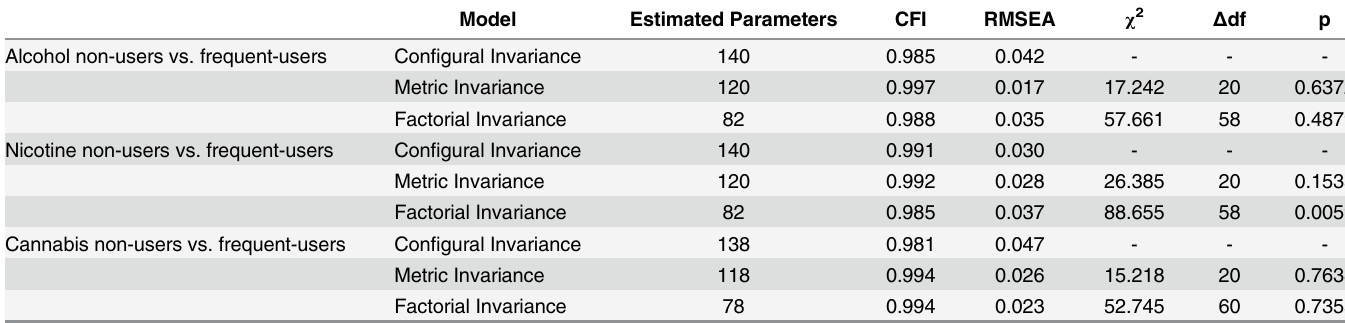
Table 3. Measurement invariance model goodness-of-fit statistics for non-users and frequent-users of alcohol, nicotine and cannabis.